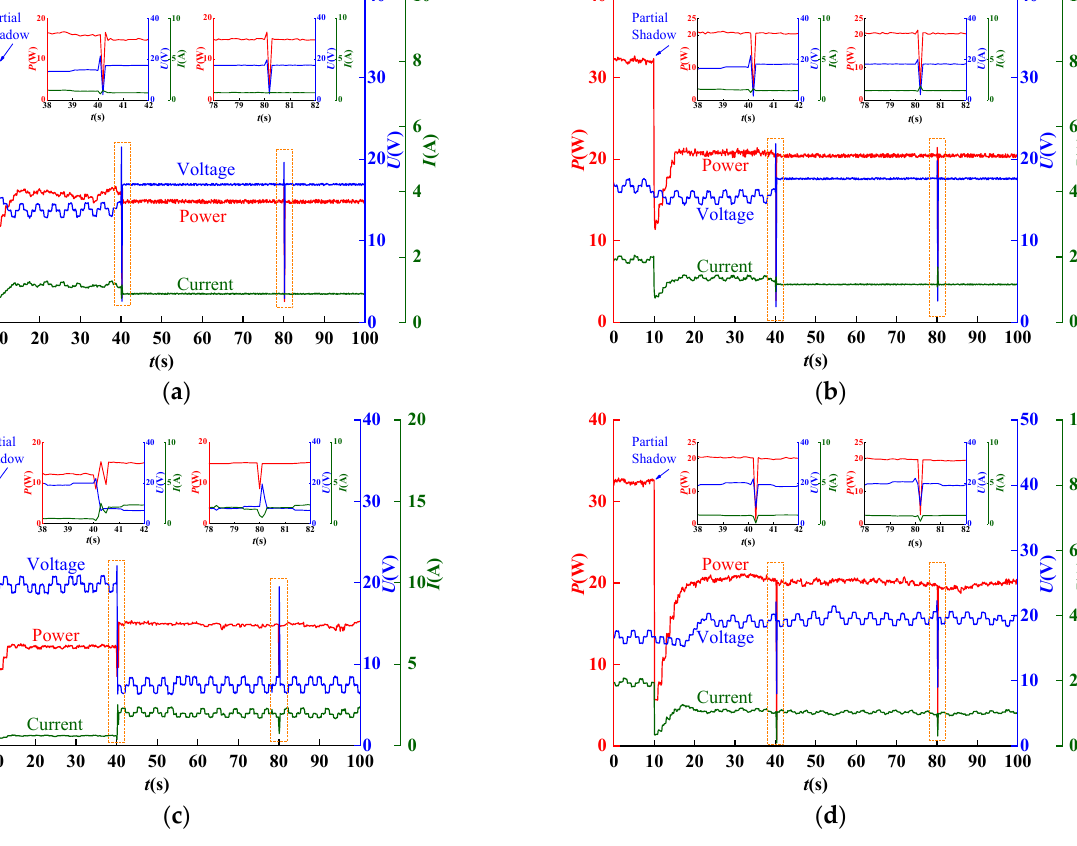
Figure 14. Experimental results of the hot-spot diagnosis control algorithm under different β : ( a ) Cover hot-spot unit ( β = 0.3); ( b ) Cover hot-spot unit ( β = 0.5); ( c ) Cover normal unit ( β = 0.3); and ( d ) Cover normal unit ( β = 0.5). Table 4. Temperature data measured in this